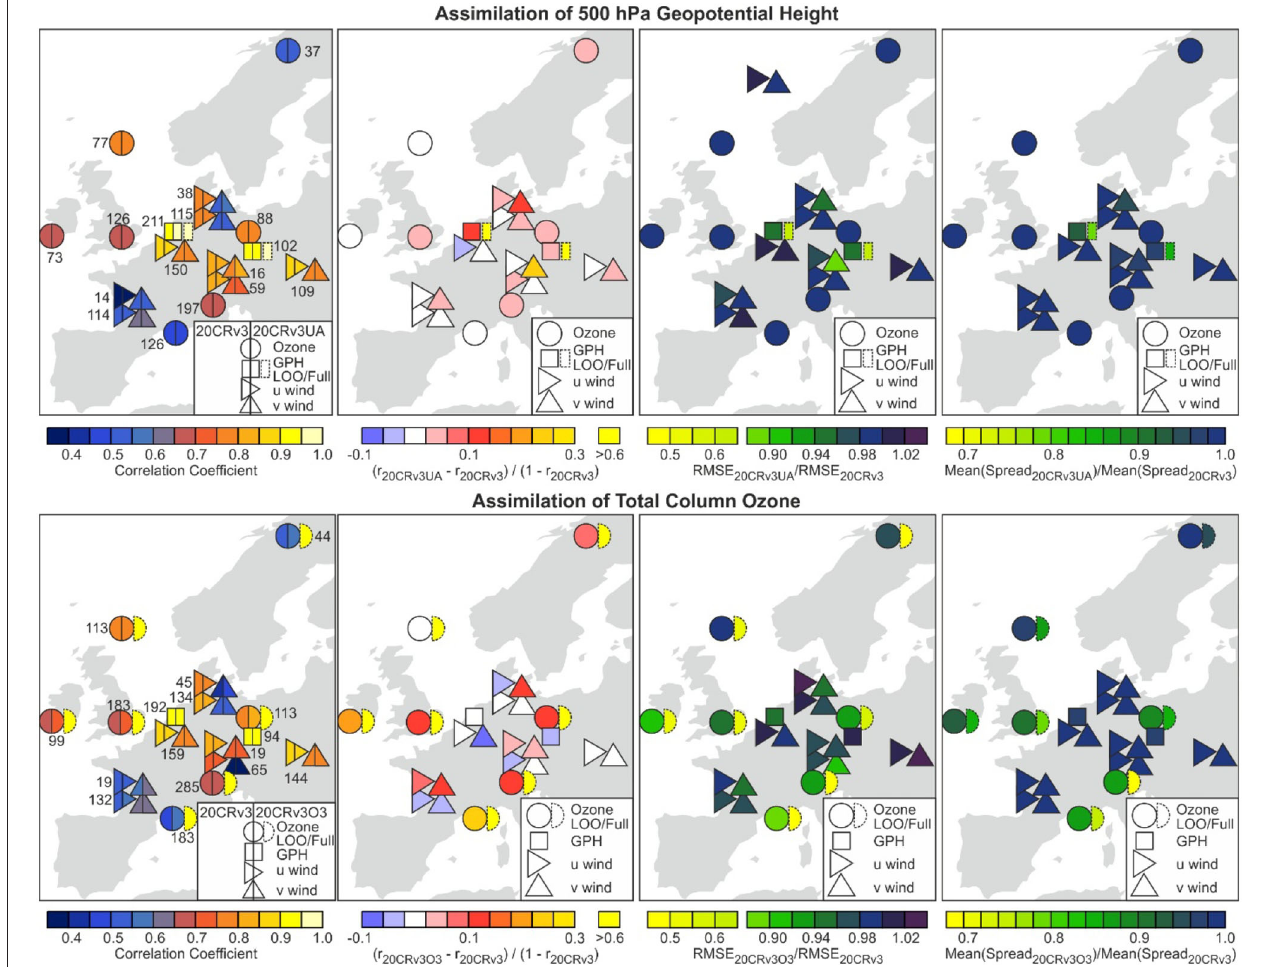
FIGURE 7 | Results of the 1926/27 experiment for correlation, scaled improvement, ratio of RMSE, and ratio of ensemble spread for the assimilation of 500 hPa geopotential height (top) and total column ozone (bottom). The numbers in the left panels indicate the observation pairs used for each correlation. Dashed outlines indicate results from the FULL assimilation that are not independent, solid outlines are based on independent data (data retained for evaluation or LOO